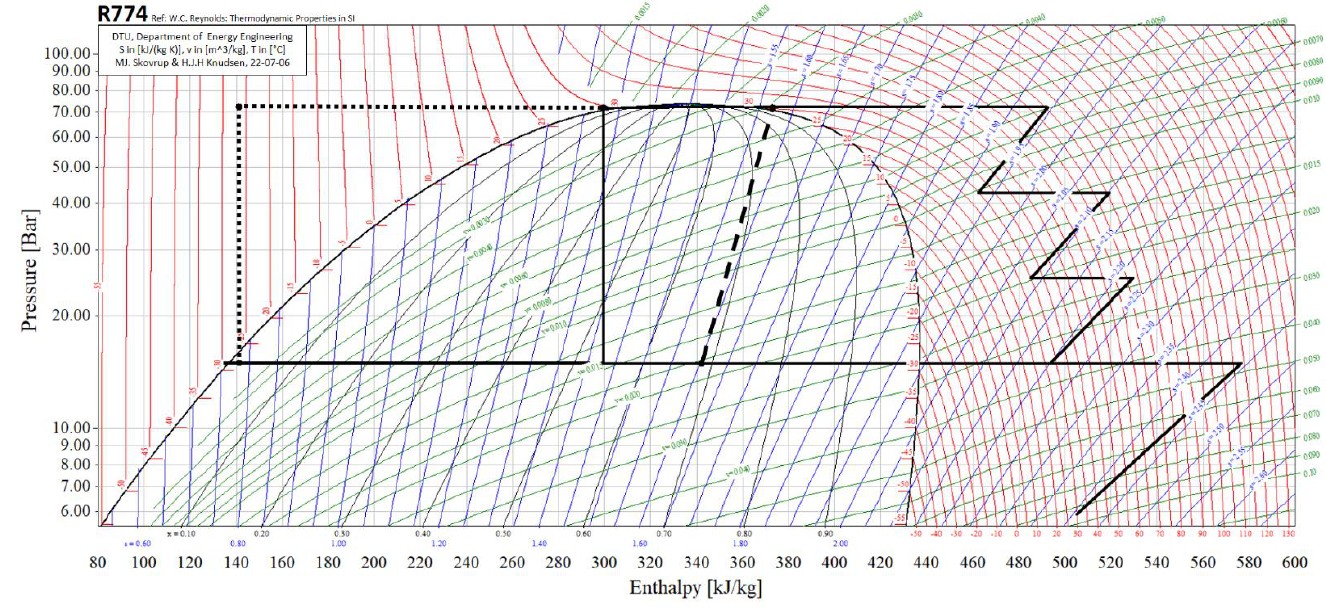
Figure 2. Process flow diagram for the open-cycle liquefaction design with a control valve.